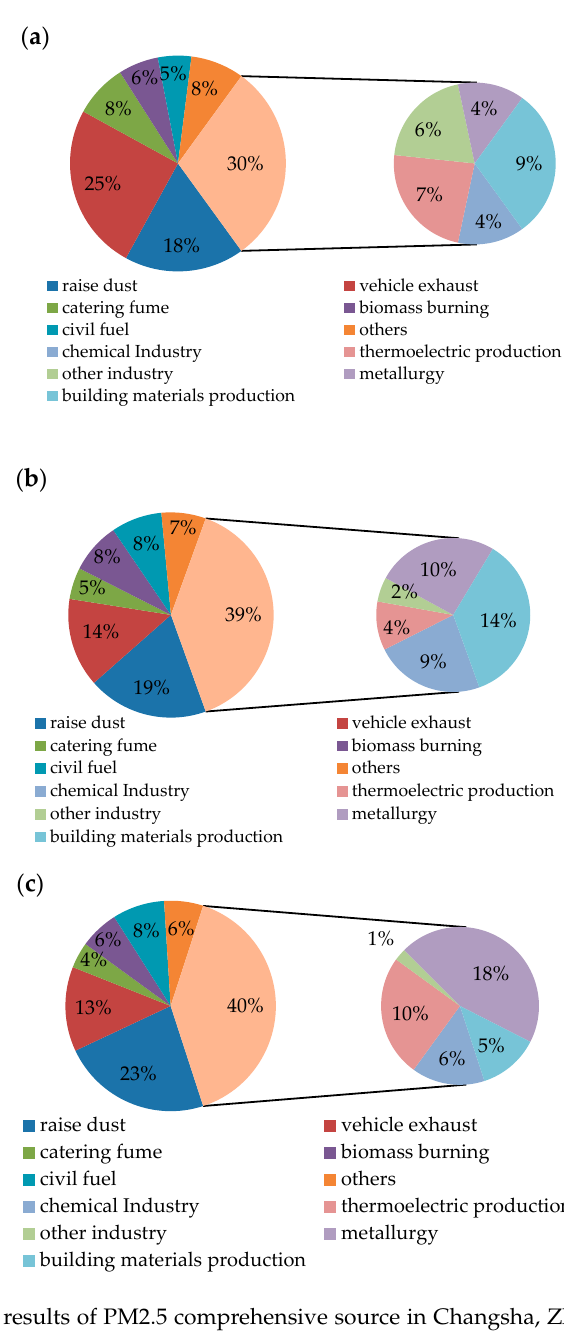
Figure 7. Analytical results of PM2.5 comprehensive source in Changsha, Zhuzhou, and Xiangtan. ( a ) Changsha. ( b ) Zhuzhou. ( c ) Xiangtan.